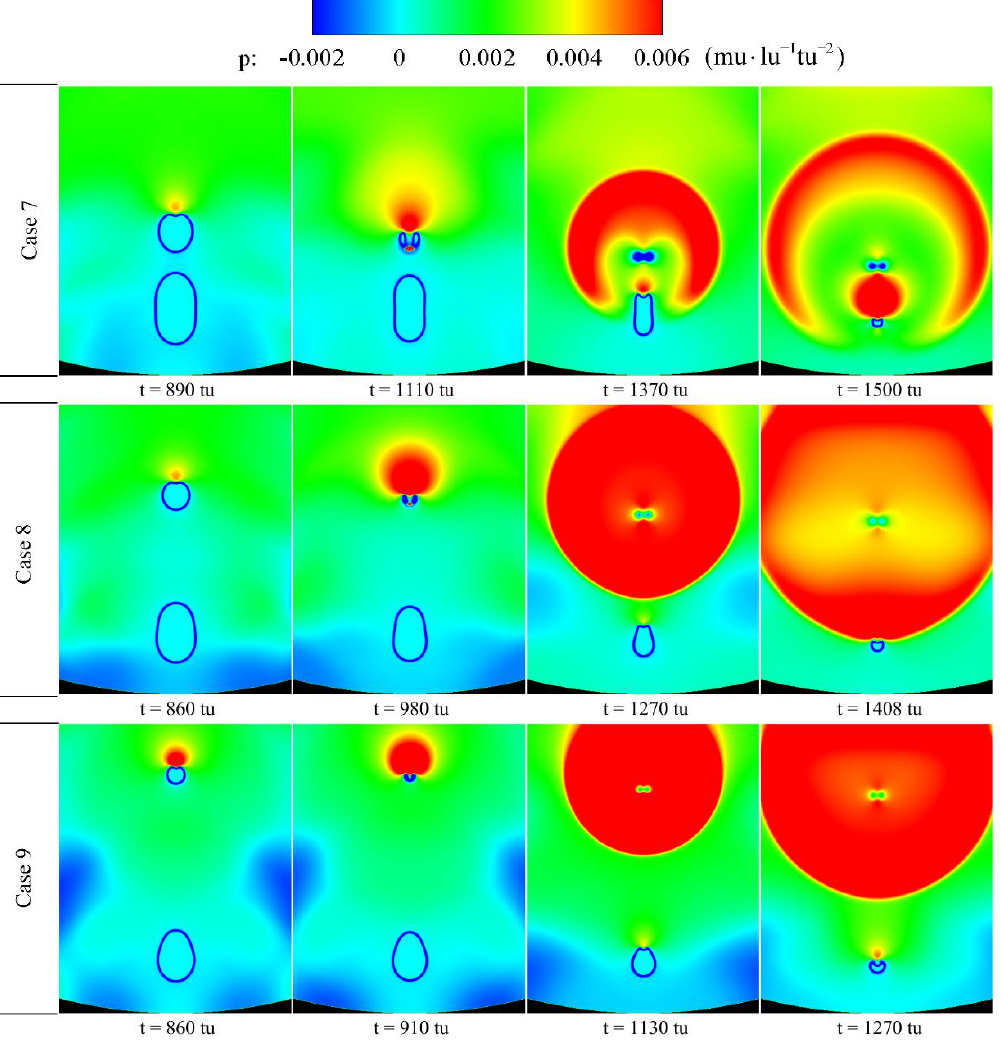
Figure 13. Pressure field of cavitation-bubble collapse for Cases 7–9.